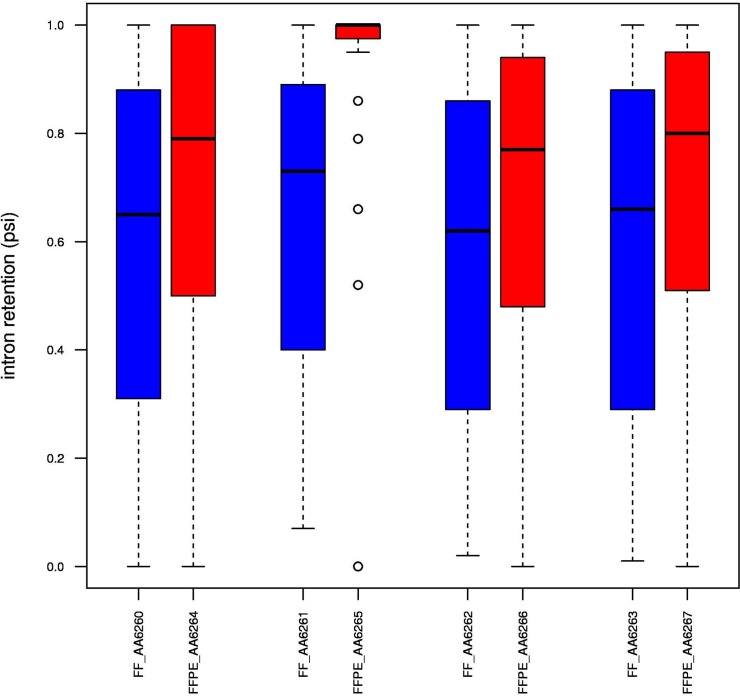
Boxplots of PSI values for intron retention events.Results for FF samples are shown in blue and those for FFPE samples in red. The PSI value was defined as the number of reads supporting the inclusion divided by the number of reads supporting the inclusion or the exclusion. The median PSI value for intron retention events was higher in FFPE samples, suggesting a greater abundance of transcripts with unspliced introns, such as pre-mRNAs or linc-RNAs.